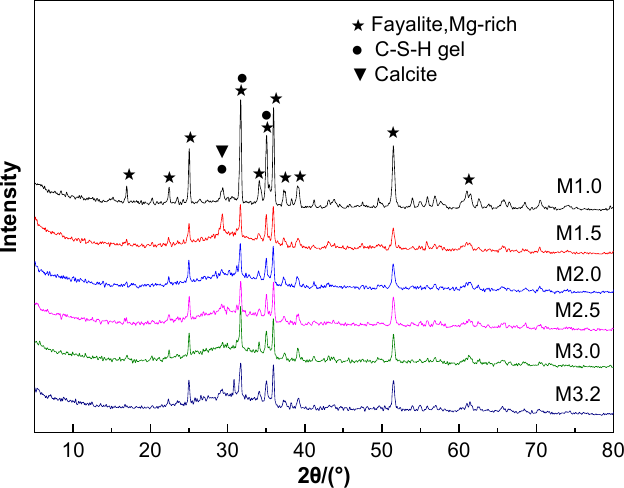
Figure 5. Effect of sodium silicate solution modulus on the compressive strength of alkali-activated CNS material.